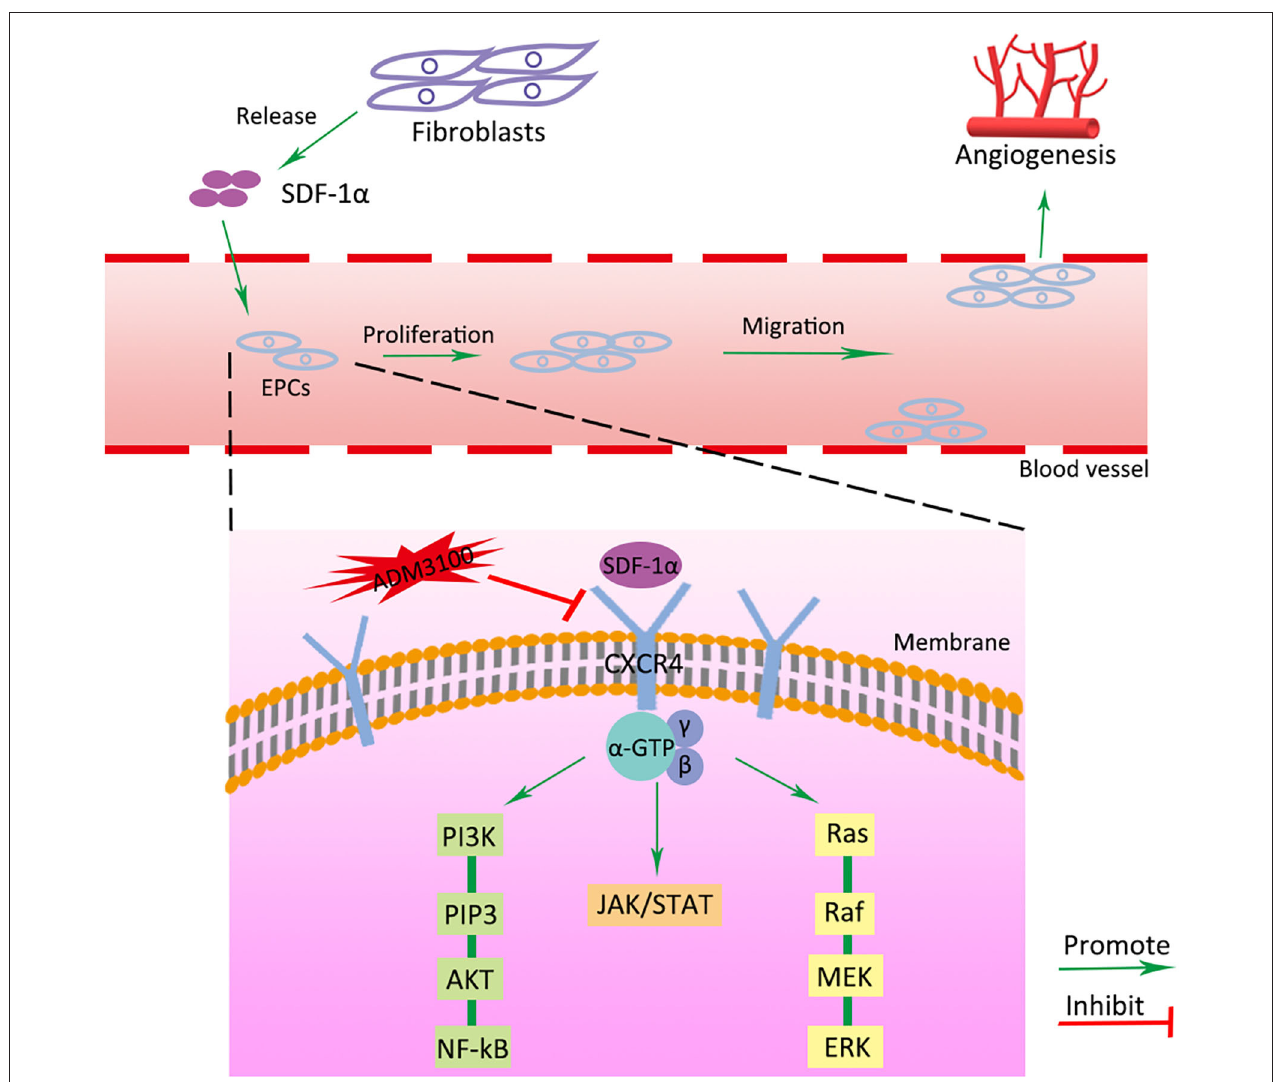
FIGURE 9 | Schematic diagram of SDF-1 α /CXCR4 signaling pathway activated by transfection of SDF-1 α modRNA into fibroblasts. Green and red arrows correspond to positive and negative regulatory effects,